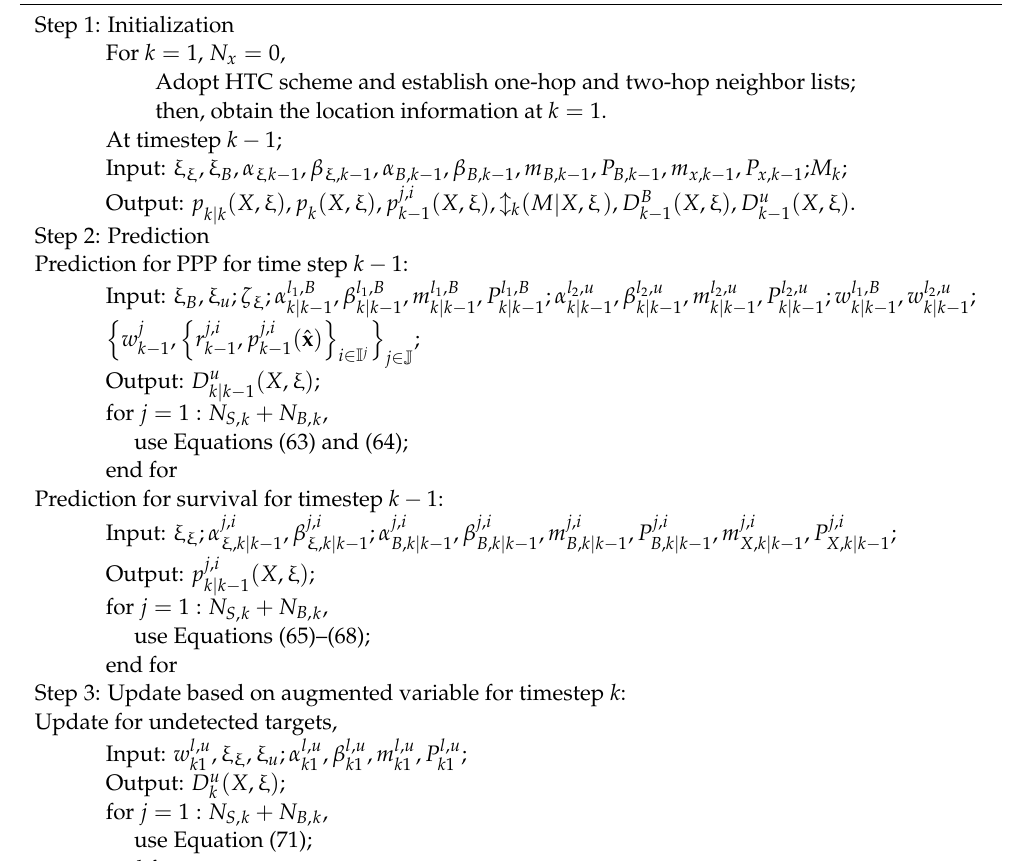
Algorithms 1 A framework of GCI-IGGM-PMBM